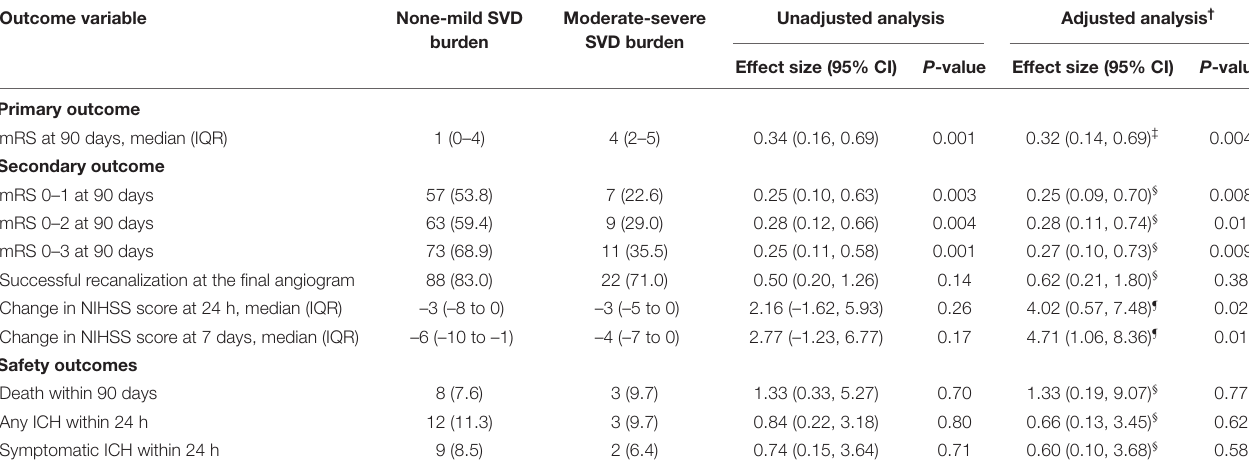
TABLE 2 | Outcome measures of patients with none-mild SVD burden vs. moderate-severe SVD burden.